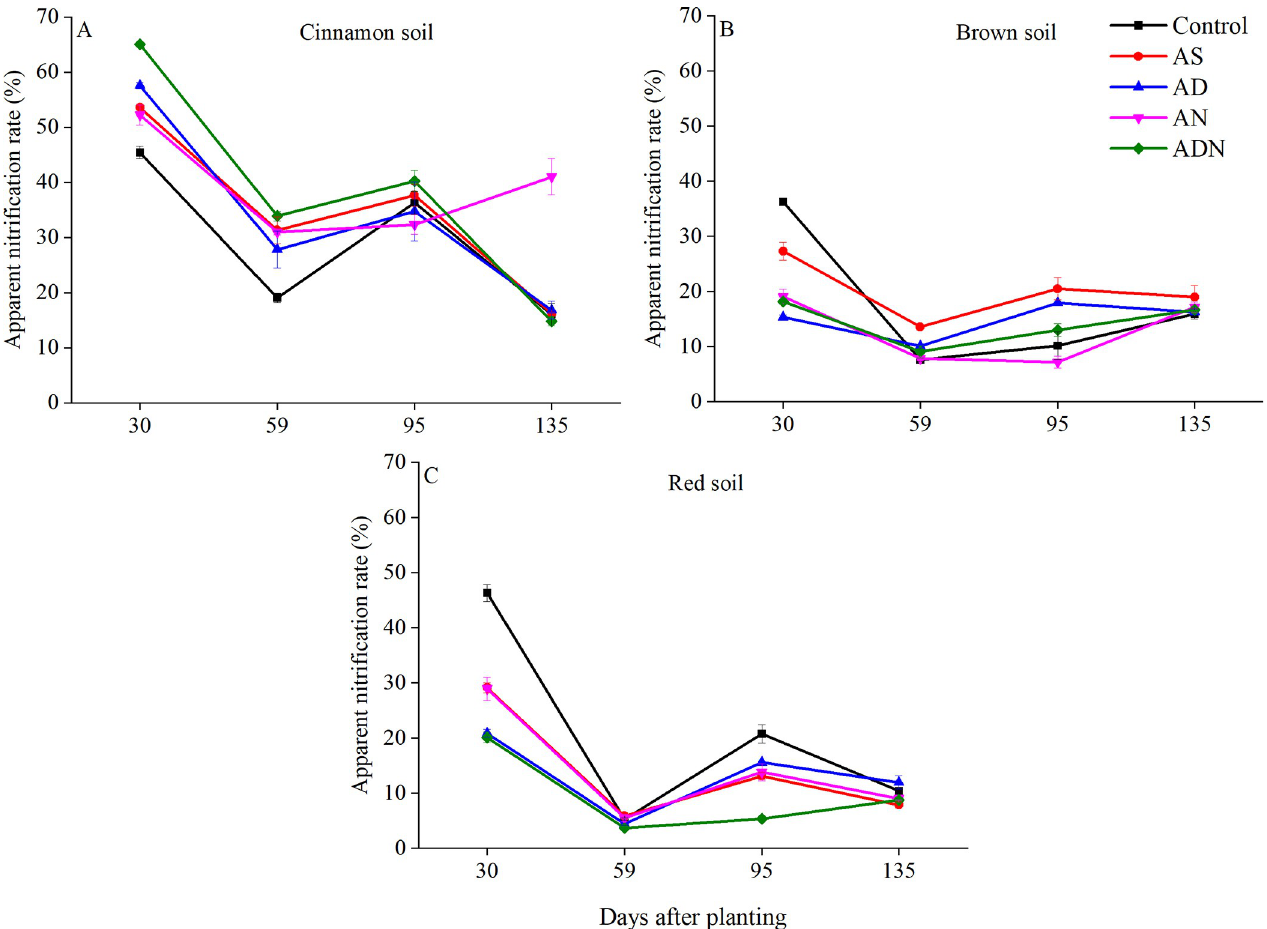
Fig 2. Changes of apparent nitrification rate of three soils during four sampling periods. Treatment: AS, ammonium sulphate; AD, AS+3, 4-dimethylpyrazole phosphate (DMPP); AN, AS+nitrogen protectant (N-GD); ADN, AS+3, 4-dimethylpyrazole phosphate (DMPP)+nitrogen protectant (N-GD). Error bars represented standard deviations ( n =